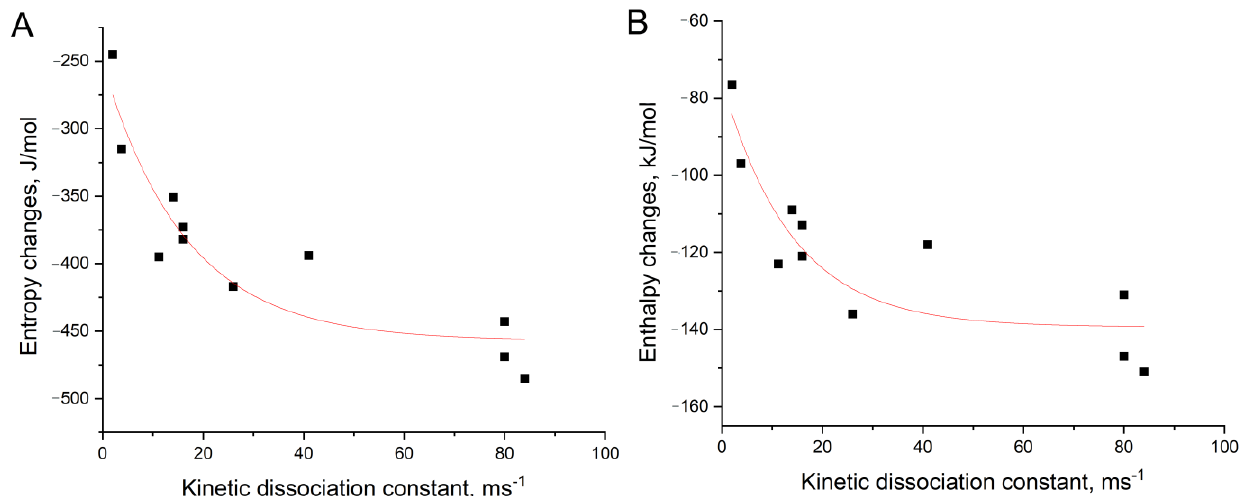
Figure 8. The relationship between thermodynamic parameters of G-quadruplex and characteristics of aptamer–thrombin complexes. ( A ) a correlation between the kinetic dissociation constant and the entropy change of G-quadruplex folding. ( B ) a correlation between the kinetic dissociation constant and the enthalpy change of the G-quadruplex folding.